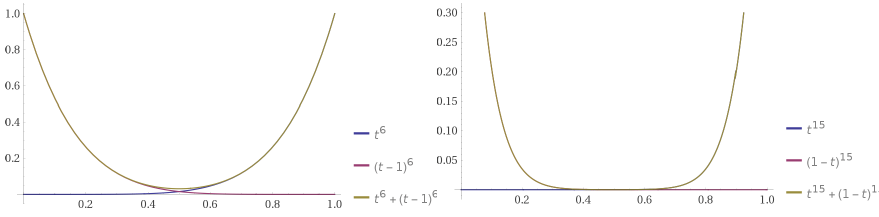
Figure 8. The expected number of monochromatic K 4 and K 5 s as a function of t . The Goodman-type upper bound for K 4 is 0.0295, and 0.00183 for K 5